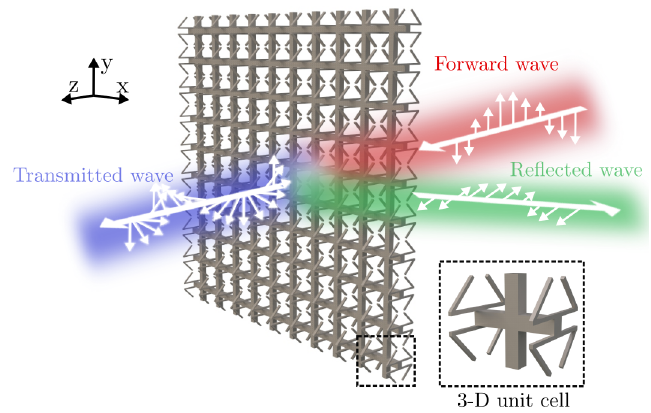
Figure 1. A conceptual illustration of a 3-D metamaterial controlling the flow of